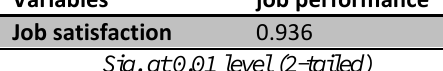
Table 4. Pearson correlation coefficient between job satisfaction in general and job performance Variables